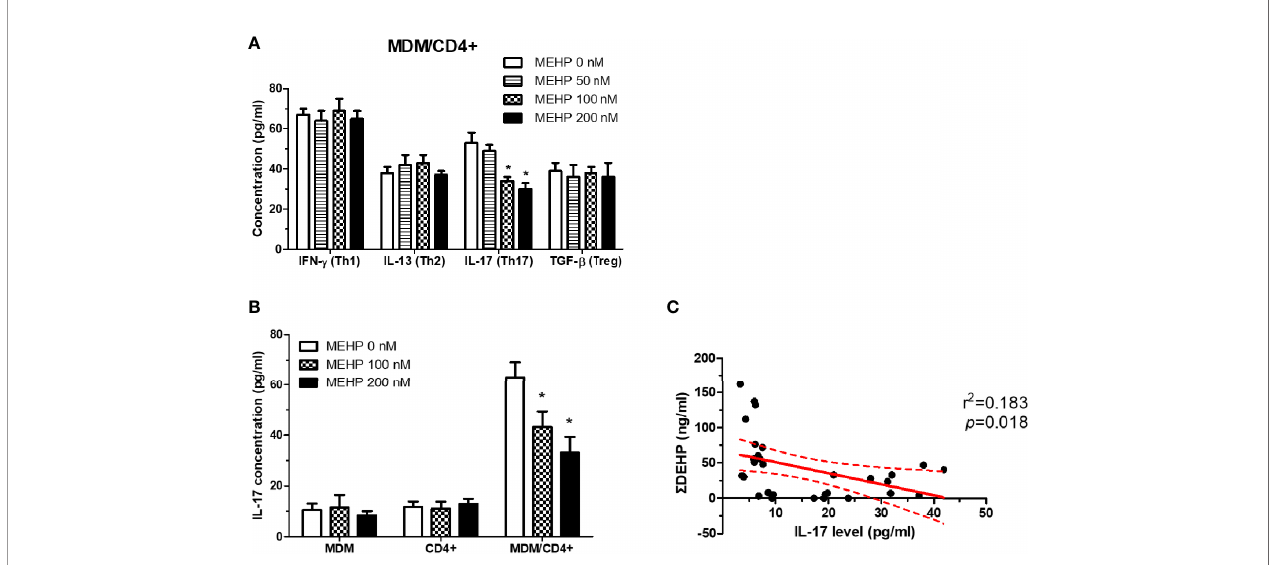
FIGURE 3 | MEHP decreases the Th17 response in cultured human MDMs. (A) Cytokines released in supernatants from co-cultured monocyte-derived macrophage (MDM)/CD4+ cells with or without MEHP treatments were tested by ELISA. *P < 0.05 MEHP-treated vs. controls by Kruskal-Wallis test; N = 8, means ± SD. (B) IL-17 release in MDMs, CD4+ cells, and co-cultured MDM/CD4+ cells was tested by ELISA. *P < 0.05 MEHP-treated vs. controls by Kruskal-Wallis test; N = 3, means ± SD. (C) The urine MEHP level showed a negative correlation tendency with serum IL-17 levels in dengue virus (DV)-infected patients. N = 43 by linear regression analysis.